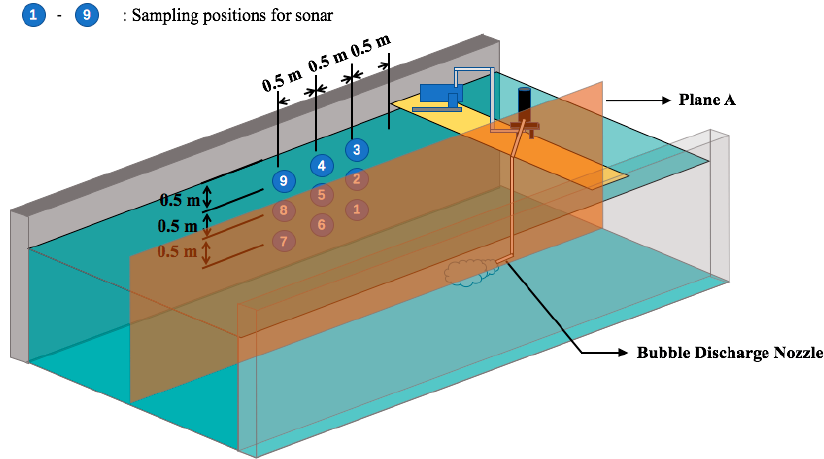
Figure 12. Sketch of plane A that intersected the release nozzle and was parallel to the sidewall of the tank which was used for measuring the residence time of bubbles.